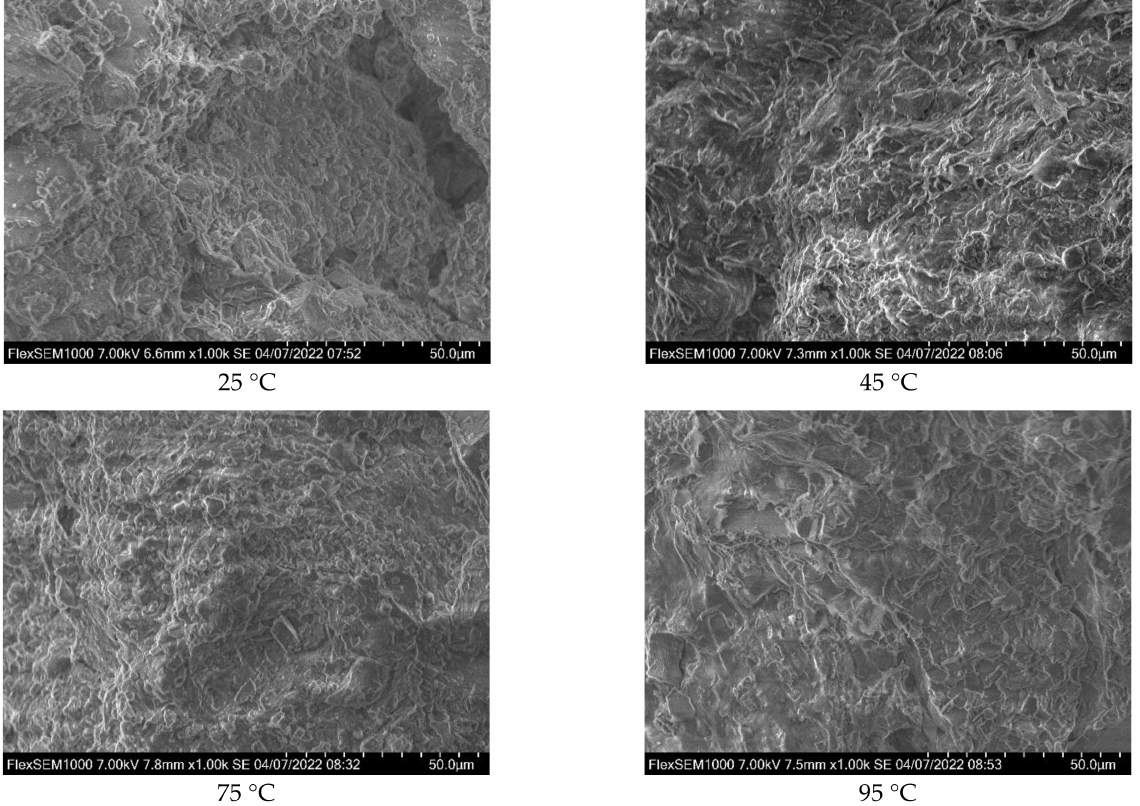
Figure 14. SEM photos of sandstone specimens treated by water bath at different